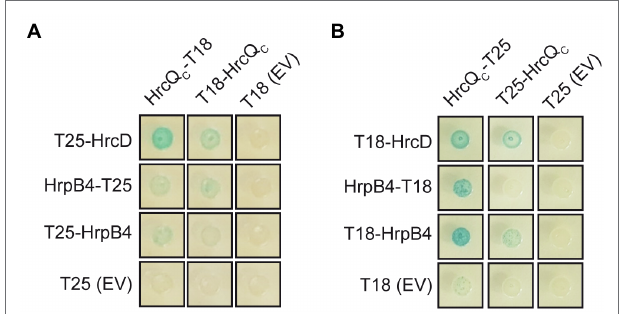
FIGURE 6 | HrcQ C interacts with HrcD and HrpB4. (A,B) HrcQ C interacts with HrcD and HrpB4. T25 and T18 fusions of HrcQ C , HrpB4, and HrcD were cotransformed into DHM1 cells as indicated. As controls, T18 and T25 fusions were cotransformed with the corresponding empty vectors (EV) encoding T18 or T25. Bacterial cultures were grown on indicator plates and photographs were taken after 3 days. Spots of one representative culture per interaction are shown. All fusion proteins were stably synthesized as shown previously (Otten and Büttner, 2021). Cotransformations were performed three times. Four different transformants for every combination were analyzed in every experiment with similar